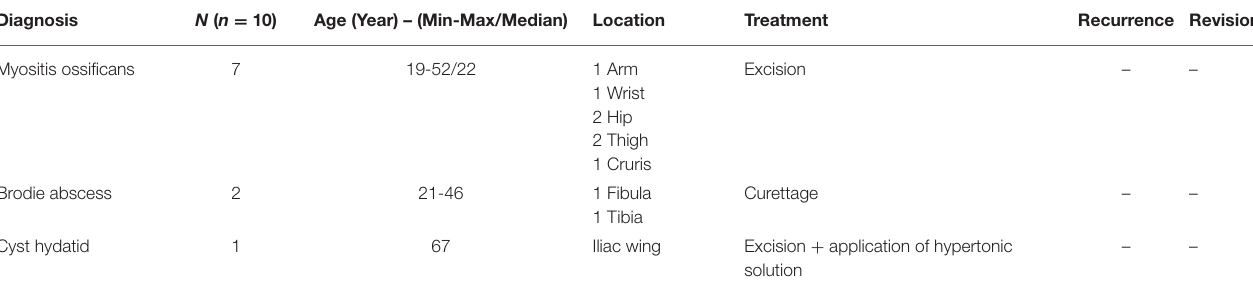
TABLE 10 | Tumor like